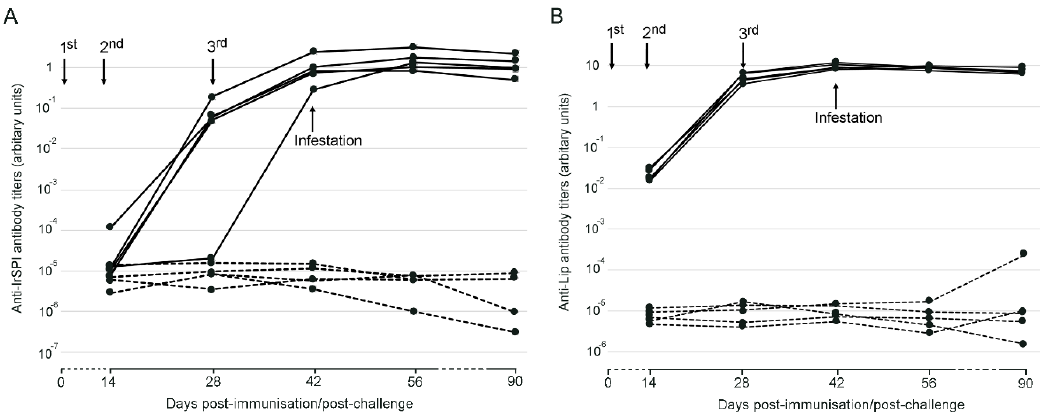
Figure 2. Antibody (immunoglobulin G1, or IgG1) response to recombinant IrSPI ( A ) and IrLip1 ( B ) in vaccinated mice. Antibody titers were determined by ELISA in serum samples collected at different time points from day 0 to day 90 against the specific protein both in vaccinated mice (solid lines) and control mice (dashed lines) that received only adjuvant. Arrows indicate dates for 1st, 2nd, and 3rd immunizations (days 0, 14, and 28) and tick infestations (Day 42). Antibody titers are represented as arbitrary units.